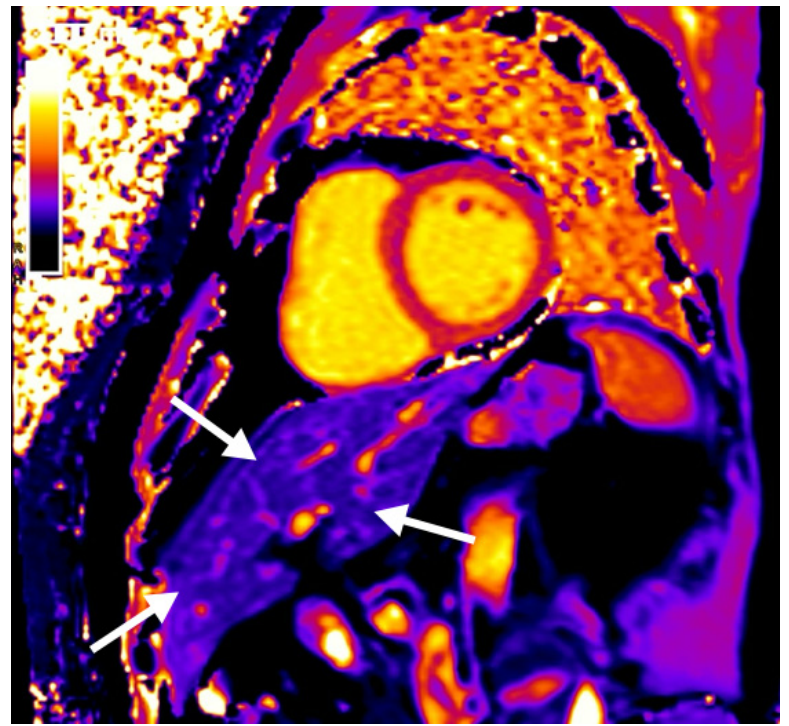
Figure 1. Standard short-axis T1-map on a cardiovascular magnetic resonance imaging study, allowing for assessment of hepatic tissue (white arrows).